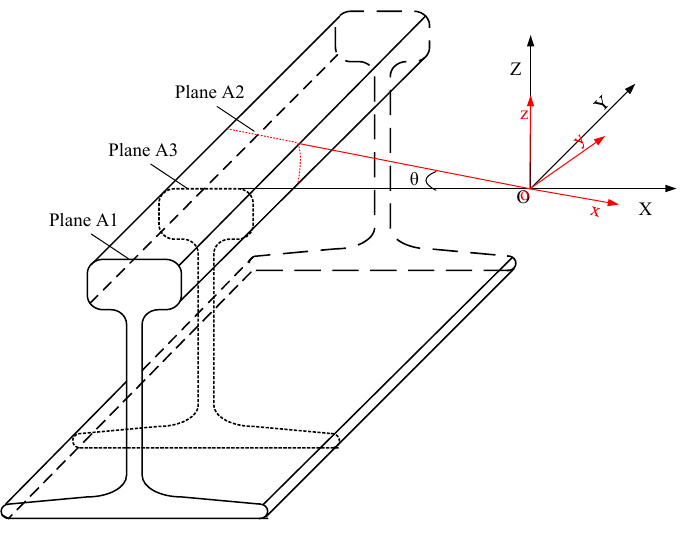
Figure 4. Motion correction